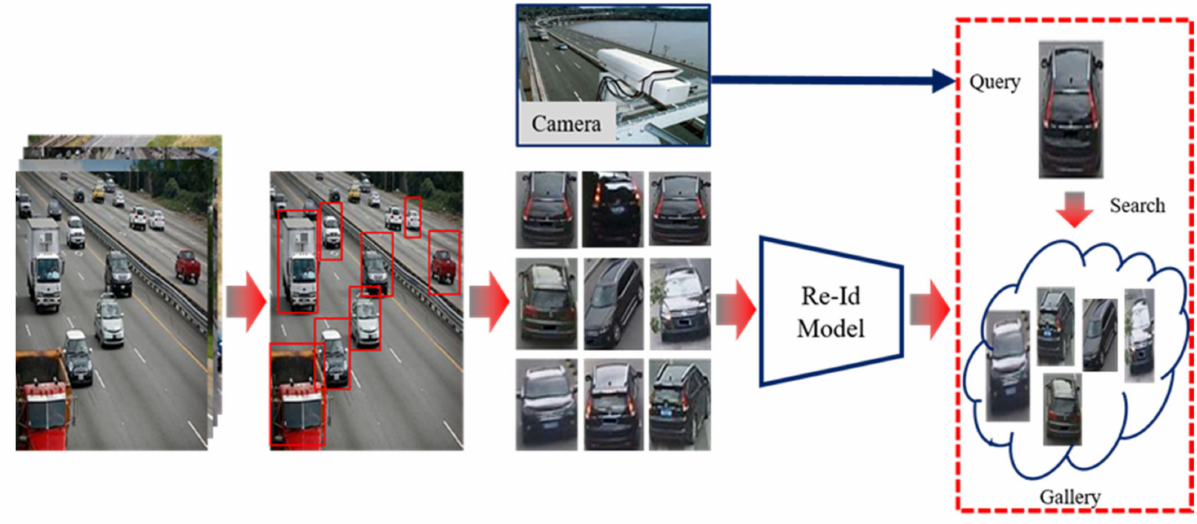
Figure 8. The flow of designing a practical vehicle re-id system, including five main